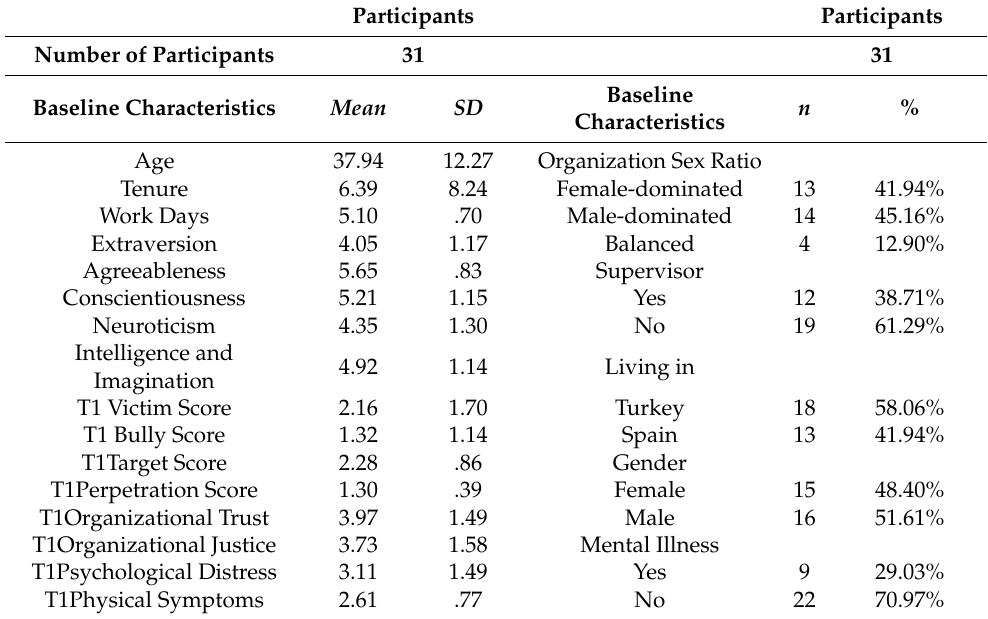
Table 1. Sociodemographic Characteristics of Participants at